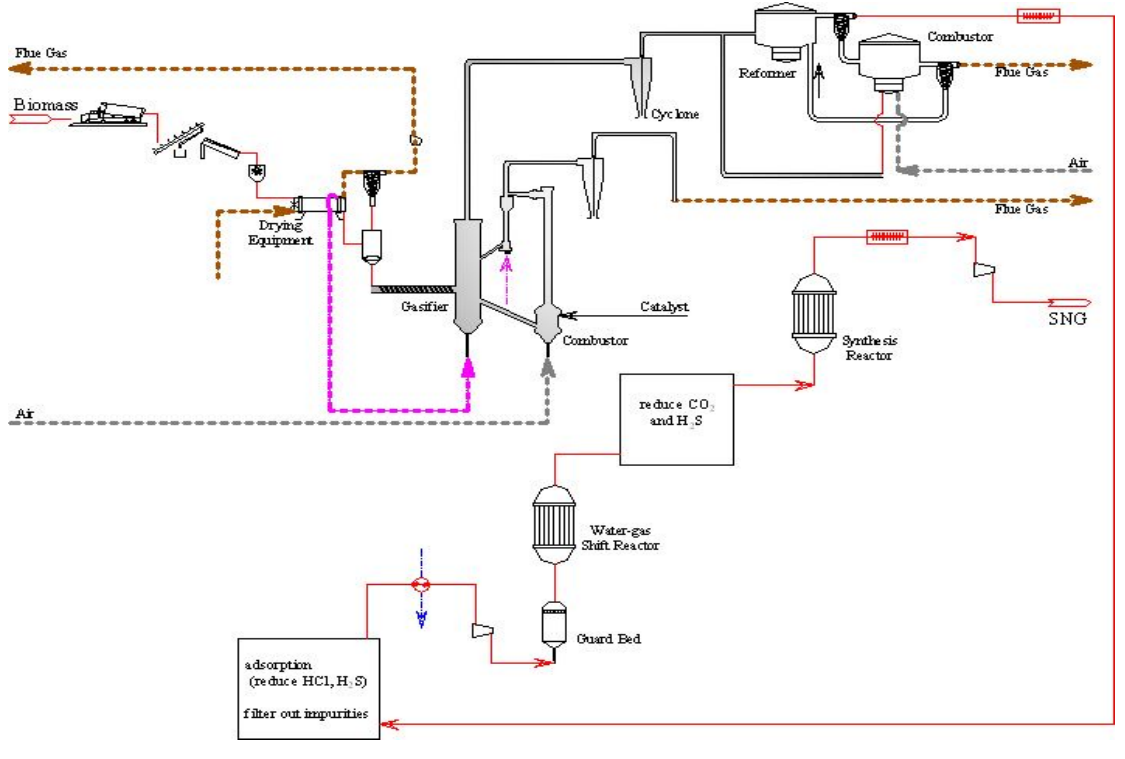
Figure 2. Model of biomass ‐ to ‐ synthetic natural gas (BtSNG) with a fluidized ‐ bed SNG synthesis system.